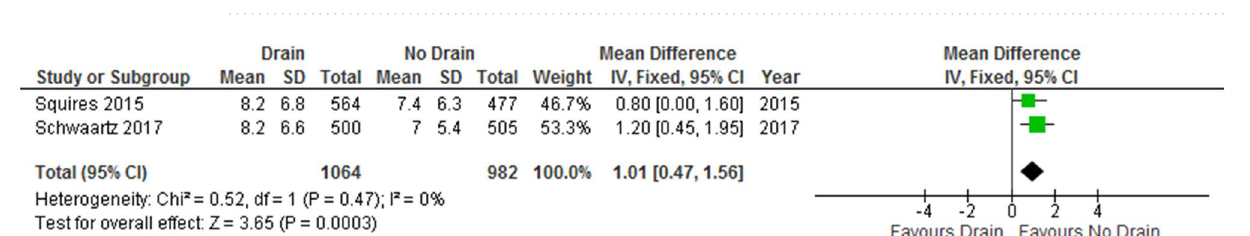
Figure 6. Forest plot of total complications.